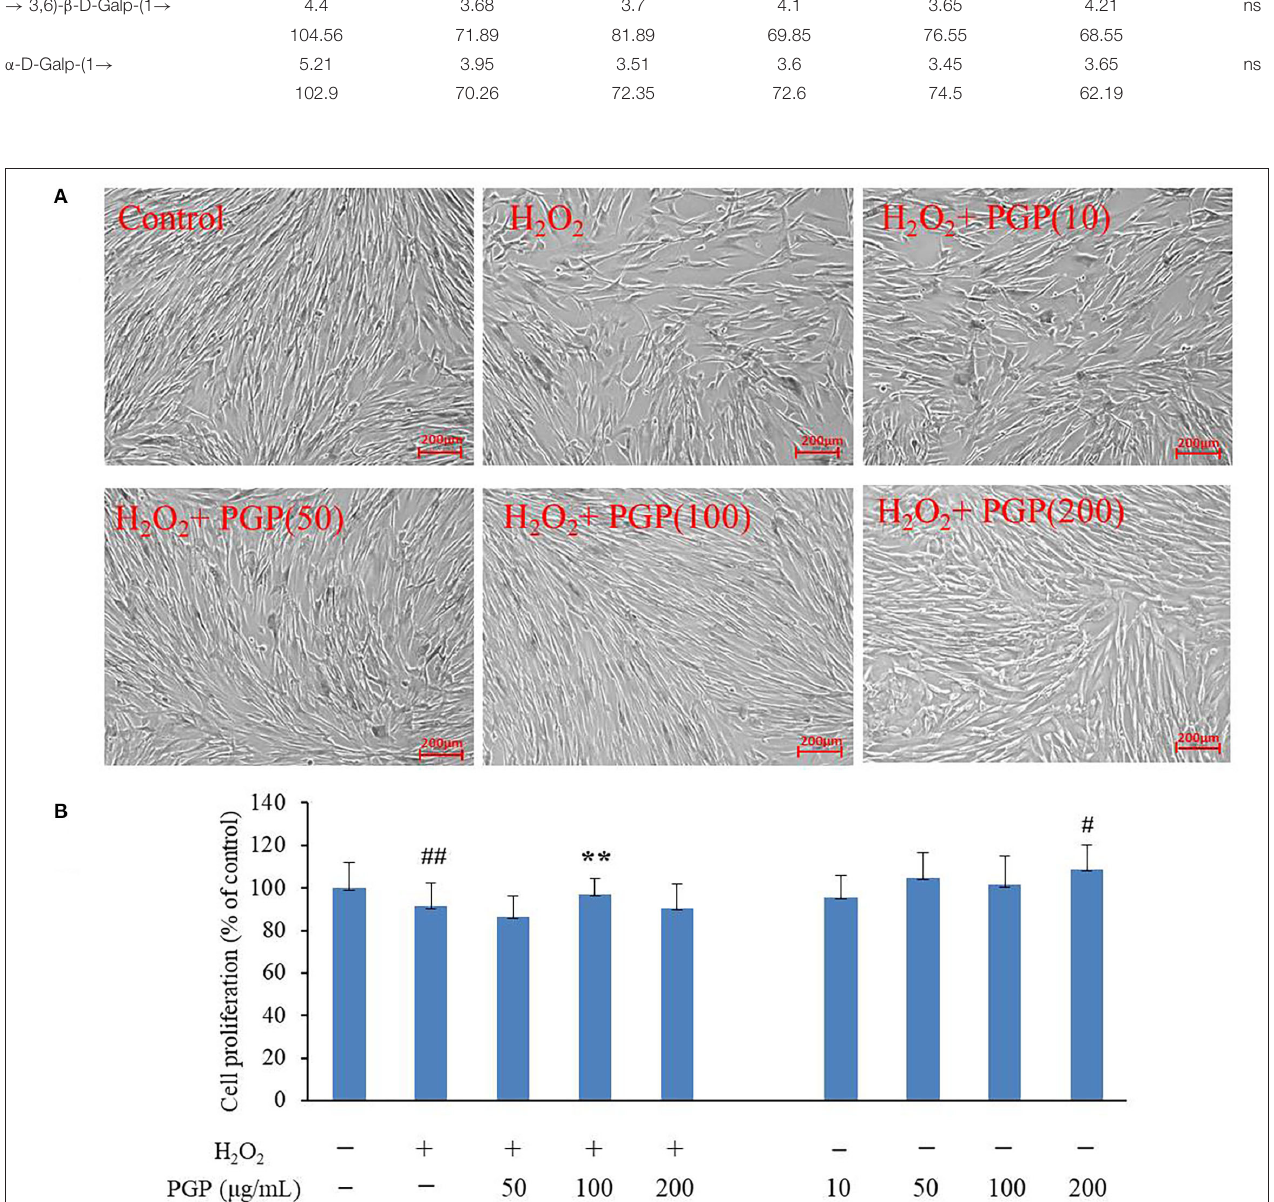
FIGURE 4 | The effect of PGP on cell morphology (A) and cell viability in H 2 O 2 -treated young 2BS cells at PD28 (B) (** p < 0.01 vs. H 2 O 2 alone group; ## p < 0.01 vs. control group). Young 2BS cells at PD28 were incubated with 200 µ M H 2 O 2 at 37 ◦ C in the culture medium for 2h. Then, H 2 O 2 -containing medium was replaced with fresh medium containing 10, 50, 100, and 200 µ g/ml of PGP for additional 72h before being morphologically observed at the magnification of 10 × . Figures are representative of three independent experiments. # p < 0.05 vs. control group.